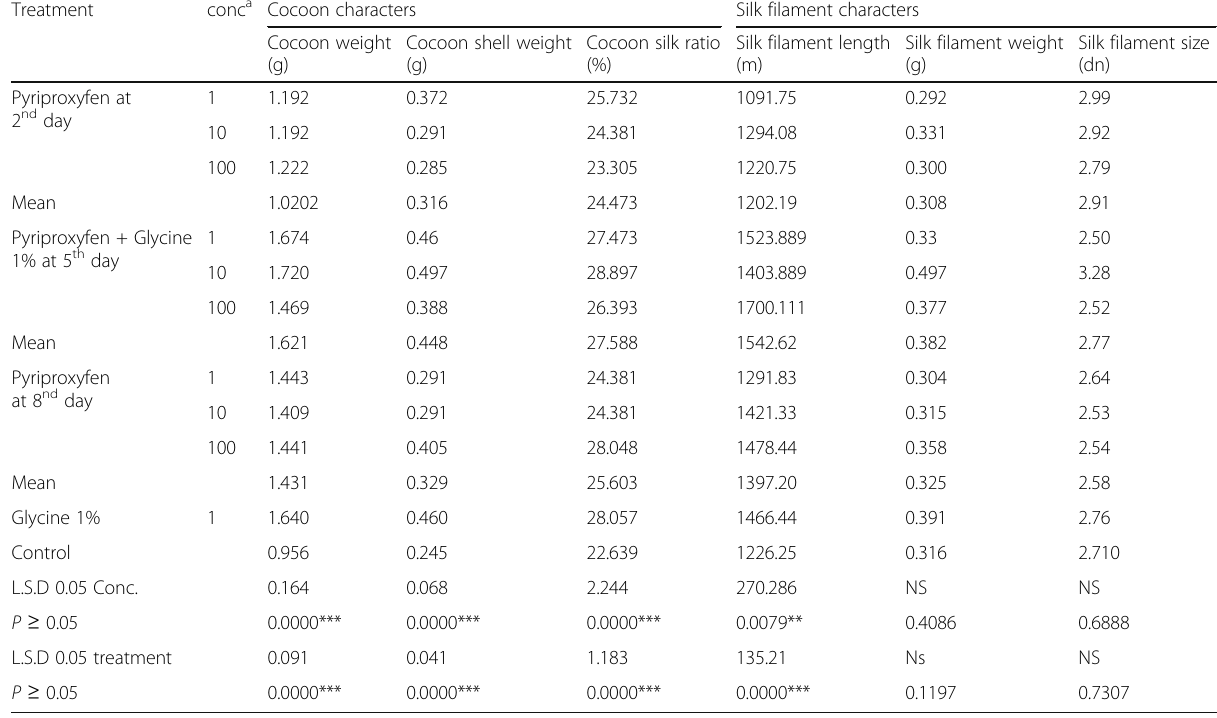
Table 2 Effect of pyriproxyfen and glycine on technological parameters (cocoon indexes and filament characters) Treatment conc a Cocoon